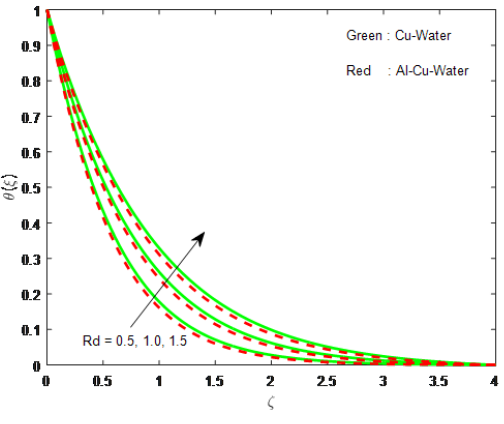
Fig. 24: Impression of Rd on θ ( ξ )